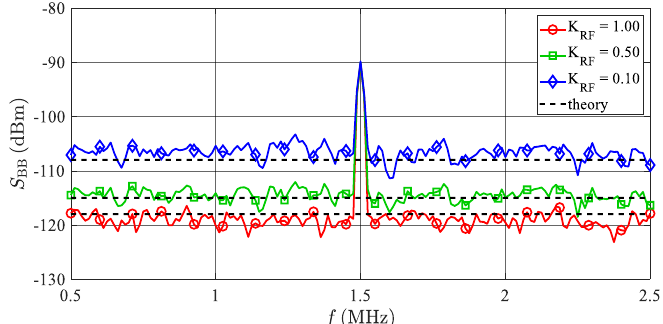
Figure 12. Simulated and calculated spectra of BB radar signals with additive RF noise. The beat signal at frequency 1.5 MHz is caused by an artificial target set to a 30-m range and an RCS equal to 10 m 2 . The amplitude of the beat signal is constant independently of the TS’s noise figure. Values of K RF = 1, 0.5 and 0.1 correspond to TS’s noise figures F S = 0, 85 and 95 dB, respectively. The “theory” lines represent the theoretical additive noise floors evaluated according to Equation (14).